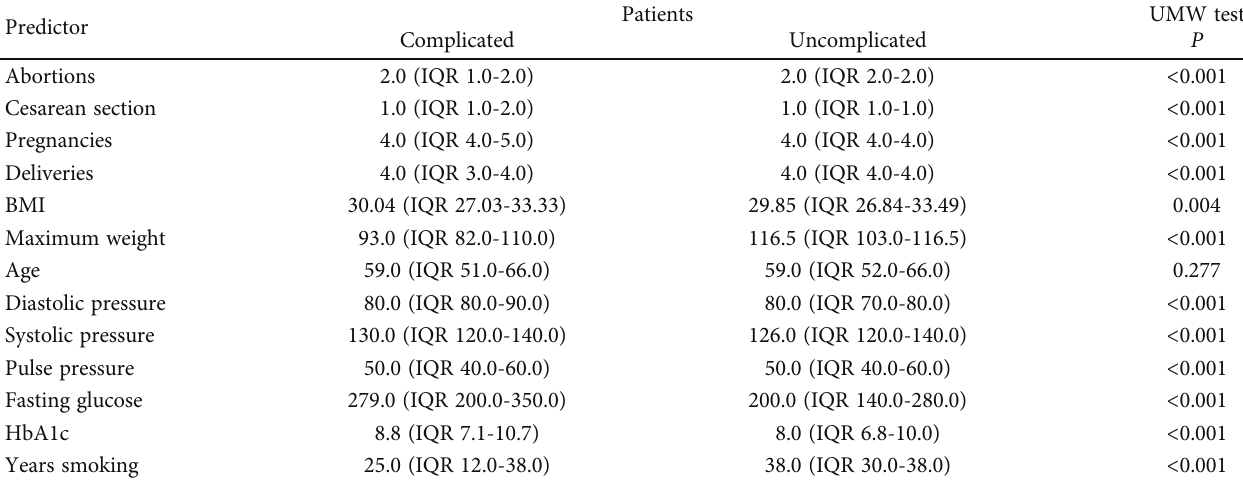
Table 5: Mann – Whitney U test for numerical variables between complicated patients versus uncomplicated